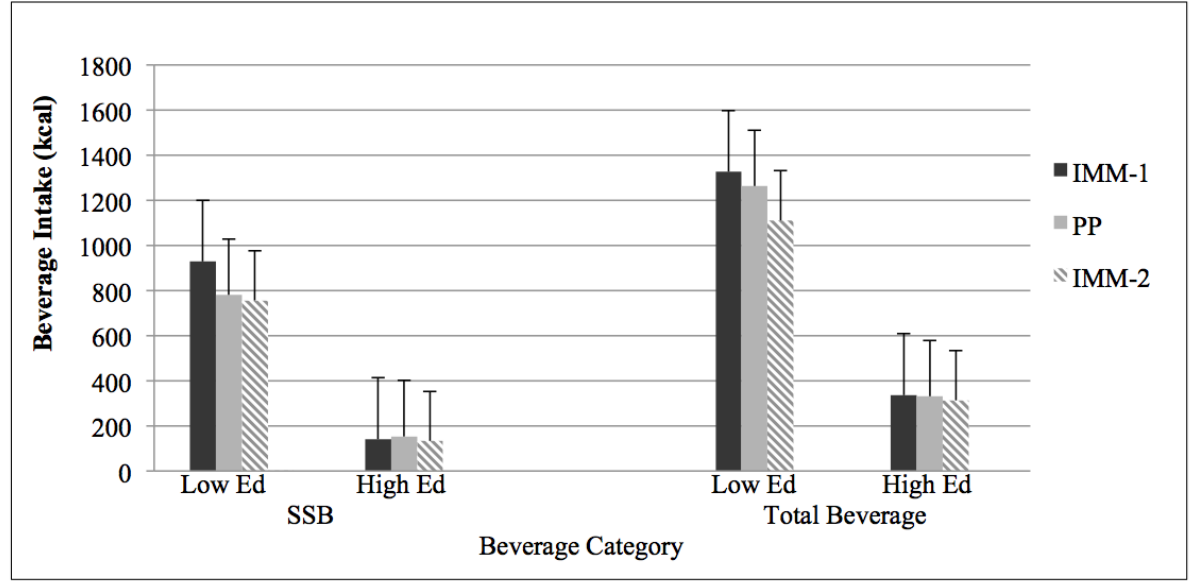
Figure 3. Beverage intake in calories (kcal) for education categories. The following abbreviations mean: Low Ed=Less than high school/high school, High Ed=Some college/college degree; SSB=Sugar-sweetened beverages; IMM=Interactive Multi-media, two separate administrations; and PP=Paper and Pencil version. The six "Low Ed" solid black, solid grey, and grey-striped bars show a significant difference from "High Ed" group ( P